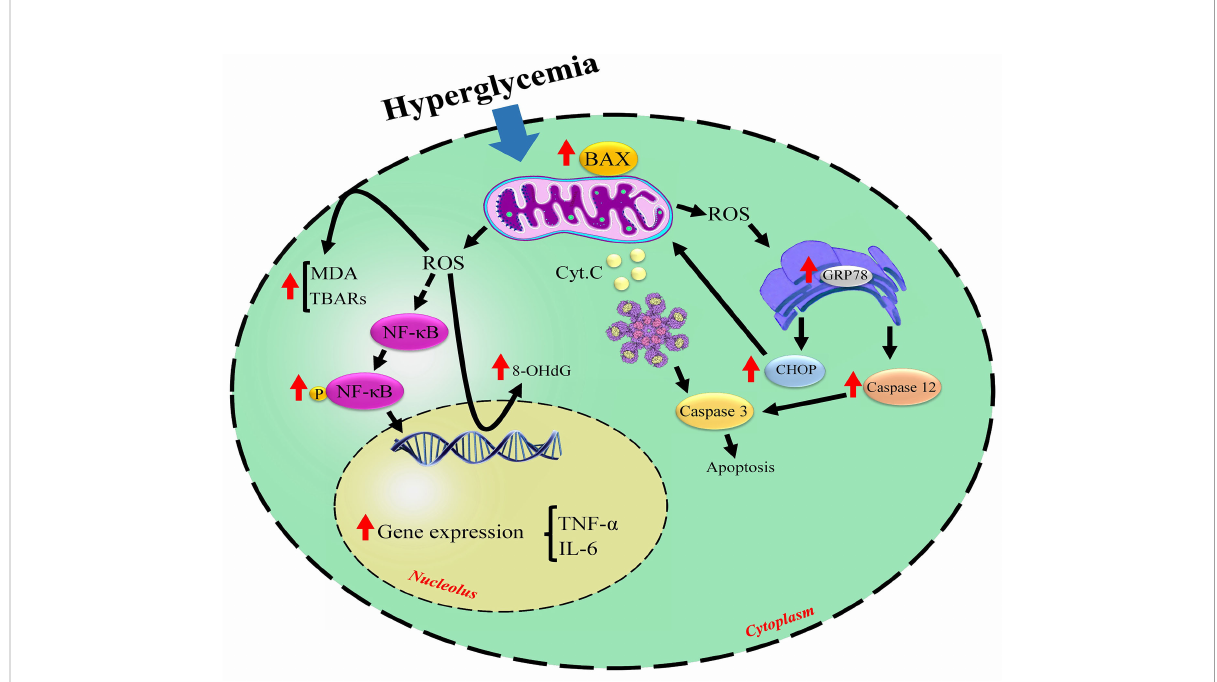
FIGURE 2 The noticed mechanisms involved in diabetes-related cellular damage. Hyperglycemia triggers excessive ROS production leading to the cell membrane and DNA damage, induces apoptosis signaling pathways, and causes in fl ammation. ↑ increased by hyperglycemia; ROS, reactive oxygen species; MDA, malondialdehyde; TBARs, thiobarbituric acid reactive substances; NF- k B, nuclear factor-kappa- b ; IL-6, interleukin 6; TNF- a , tumor necrosis factor-alpha; GRP78, 78-KD glucose-regulated protein; CHOP, C/EBP homologous protein; Cyt c, cytochrome